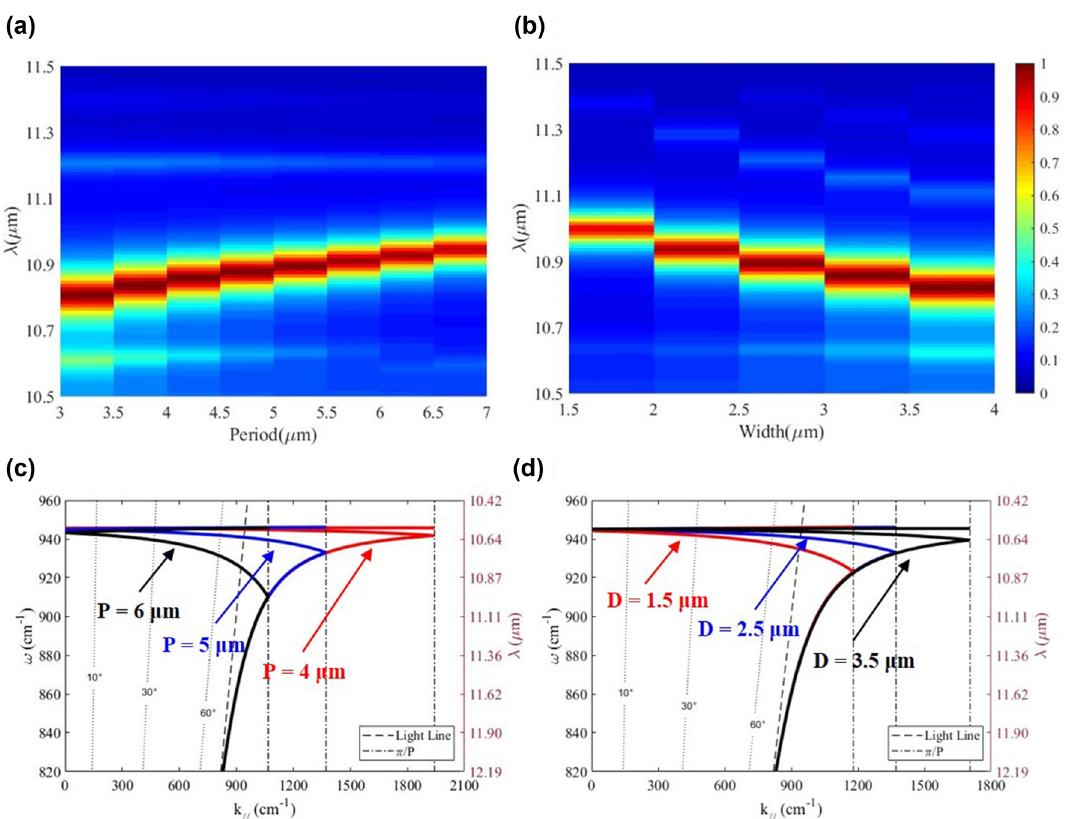
Figure 3: Dependence of thermal emissivity on the geometrical parameters. (a) and (b) Simulated emission spectrum of phonon-mediated nanostructureswithchangingperiodandwidth.In(a),P=5 μ mandH=80nm;in(b),D=2.5 μ mandH=80nm.(c)and(d)Dispersionrelation of surface phonon polaritons with different period and width. (c) Red, blue and black curves represent P = 4, 5 and 6 μ m, respectively with D = 2.5 μ m. (d) Red, blue and black curves represent D = 1.5, 2.5 and 3.5 μ m, respectively with P = 5 μ m.